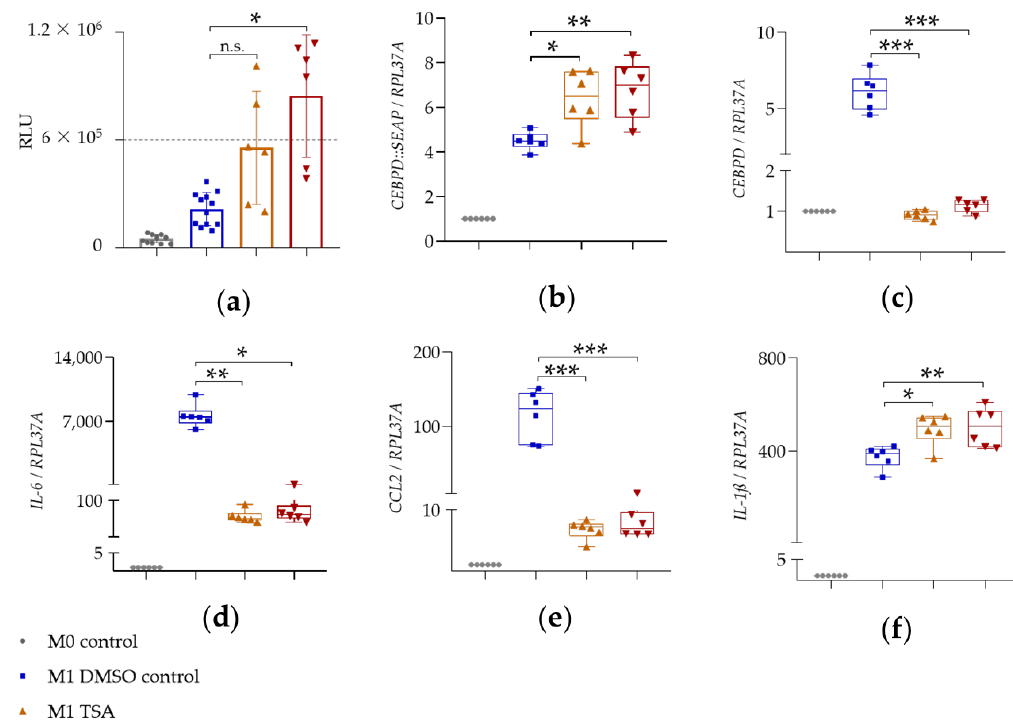
Figure 6. The effect of HDAC inhibitors SAHA and TSA on SEAP secretion and mRNA expression. In ( a ), PMA-differentiated THP-1 reporter M φ were pre-treated with 10 µ M SAHA or 0.5 µ M TSA for 1 h and stimulated with 0.1 µ g/mL LPS + 20 ng/mL IFN- γ for 24 h for SEAP assay (mean ± SD, n = 3 with 2 wells per condition). Changes in SEAP enzymatic activity were analyzed relative to M1 DMSO control via Brown–Forsythe and Welch ANOVA test with Dunnett’s correction for multiple comparisons; n.s.: not significant; * p < 0.05. In ( b – f ), PMA-differentiated THP-1 reporter M φ were pre-treated with 10 µ M SAHA or 0.5 µ M TSA for 1 h and stimulated with 0.1 µ g/mL LPS + 20 ng/mL IFN- γ for 4 h for mRNA expression analysis of reporter CEBPD::SEAP ( b ), endogenous CEBPD ( c ), IL-6 ( d ), CCL2 ( e ), and IL-1ß ( f ) (median and range, n = 3 with 2 wells per condition). mRNA expression analysis was performed via qRT-PCR ( ∆∆ Ct method) using RPL37A as an internal reference gene. Fold change in mRNA expression is displayed relative to M0 control, set as 1. The compound-mediated changes in mRNA expression were analyzed relative to M1 DMSO control via ordinary one-way ANOVA (for normally distributed data and equal SDs), Brown–Forsythe and Welch ANOVA test with Dunnett’s correction (for normally distributed data and different SDs), or Kruskal-Wallis test with Dunn ´ s correction for multiple comparisons (for non-normally distributed data). * p < 0.05; ** p < 0.005; *** p <